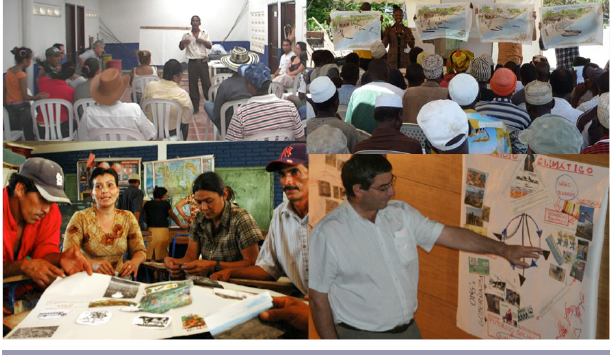
Fig. 3 . Photographs from participatory scenario planning processes in four case studies (clockwise from upper left: #13 Colombia, #17 Kenya, #22 Spain, #10